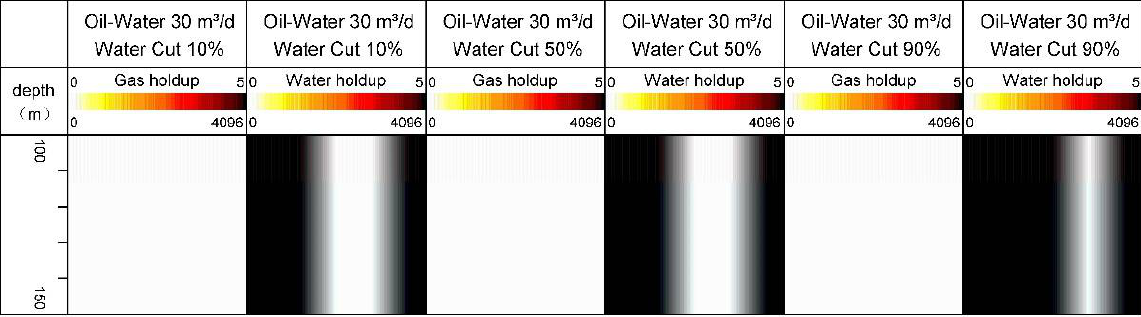
Figure 6. Response characteristics when the water cut of 30 m 3 /d of oil and water is 10%, 50%, and 90%.